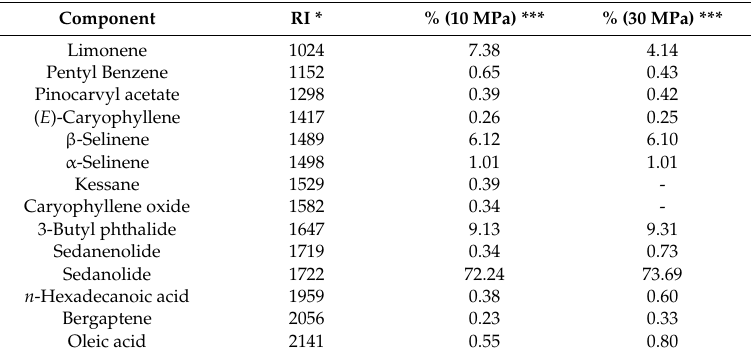
Table 2. Results of GC analysis of celery isolates.